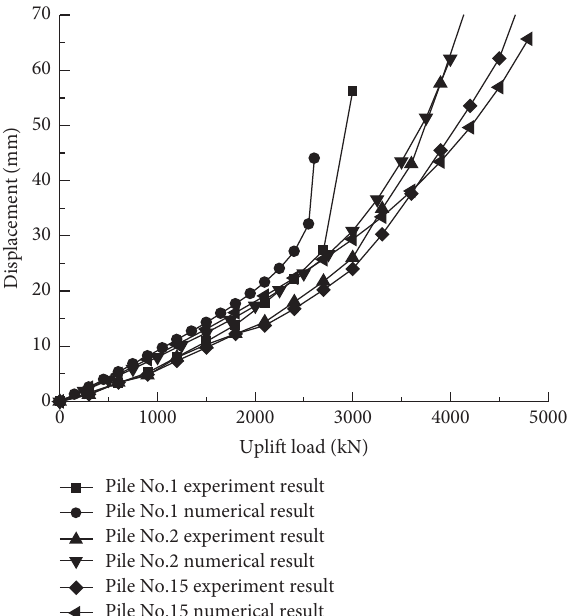
Figure 5: Comparison of experimental and numerical results.